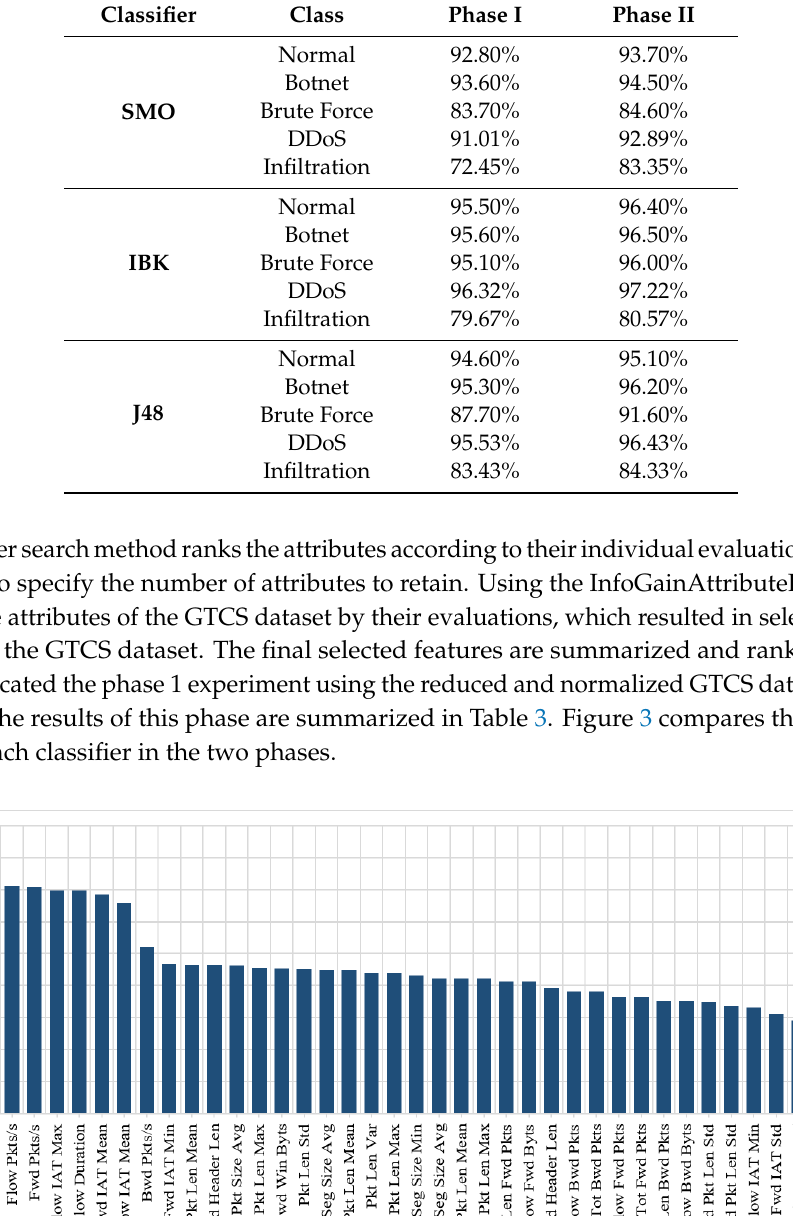
Figure 3. Classification accuracy in the two phases. The experimental results show that IBK outperformed other classifiers and had the best accuracy in both phases. Moreover, the results shown in Table 6 indicate that IBK outperformed other classifiers in classifying normal, botnet, and brute force classes, while MLP and J48 performed best at classifying DDoS and infiltration classes, respectively. These results are illustrated in Figure 4. 5.2. A Holistic Approach for IDSs Using Ensemble ML Classifiers In this section, we propose an ensemble classifier model (shown in Figure 5) composed of multiple classifiers with different learning paradigms to address the issue of the accuracy and false alarm rates in IDSs. The proposed model is composed of three ML classifiers from various classifier families. The selection of these classifiers is based on the results from the previous section. The selected classifiers are J48 (DT-C4.5), IBK (KNN), and MLP (NN). In the proposed model, the three classifiers work in parallel, and each classifier builds a different model of the data. The outputs of the